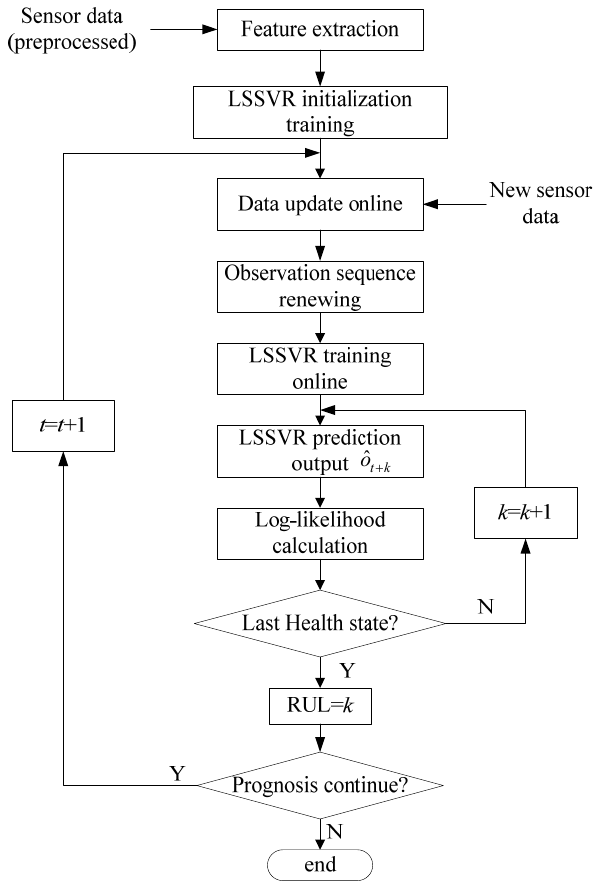
Figure 5. RUL prediction process based on the improved LSSVR with data renewed